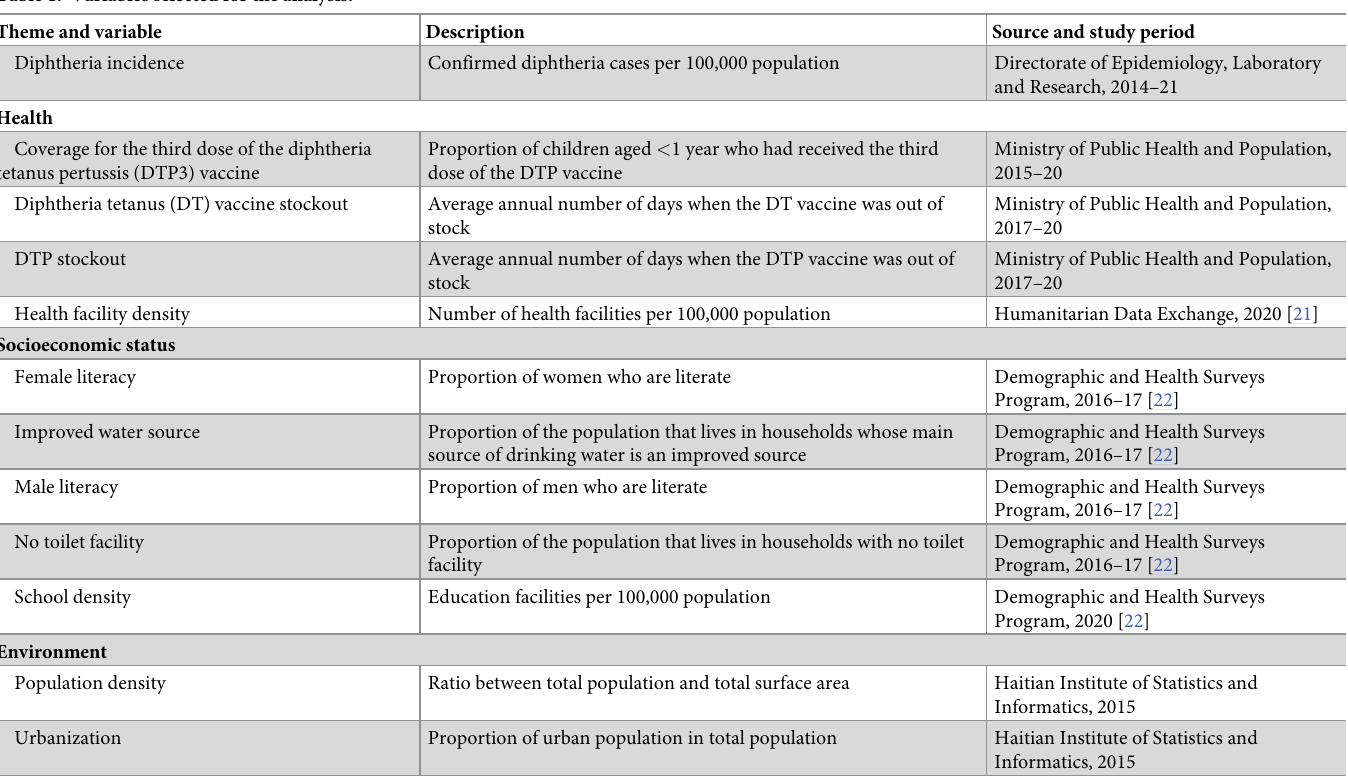
Table 1. Variables selected for the